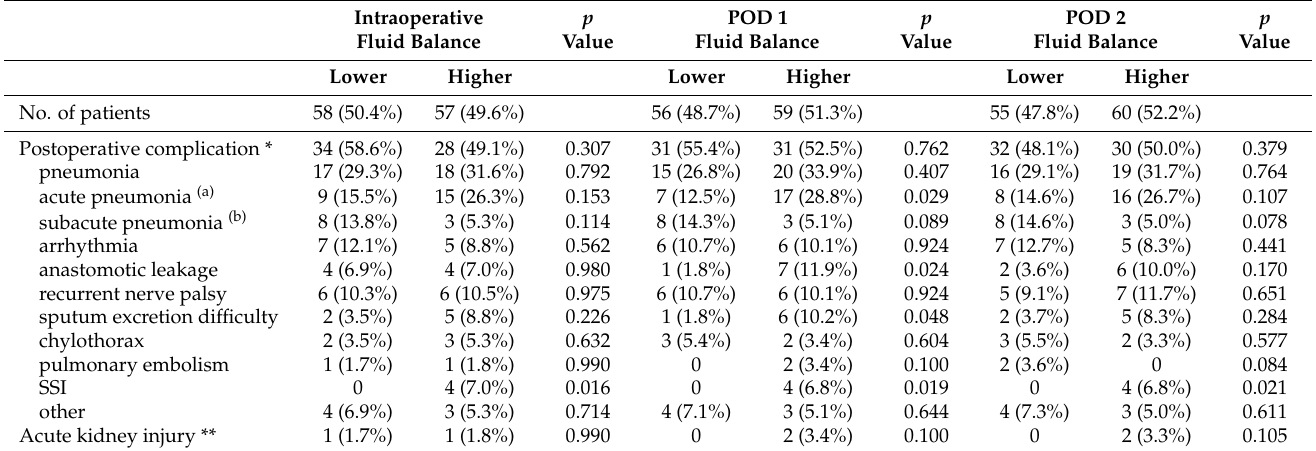
Table 1. Postoperative complications by fluid balance in the